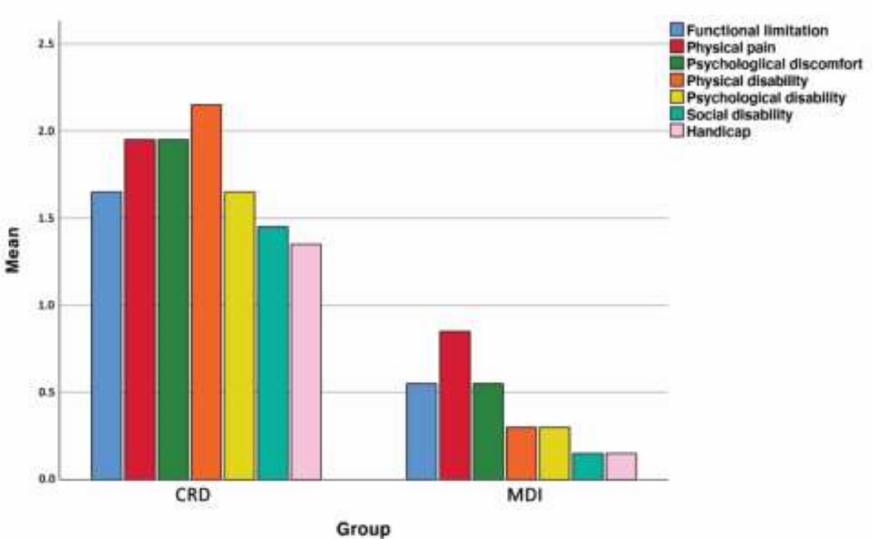
Figure 5. OHIP-14 outcome in different domains in CRD and MDI group. Significant differences were noted for psychological discomfort (dark green), physical disability (orange) and social disability (light